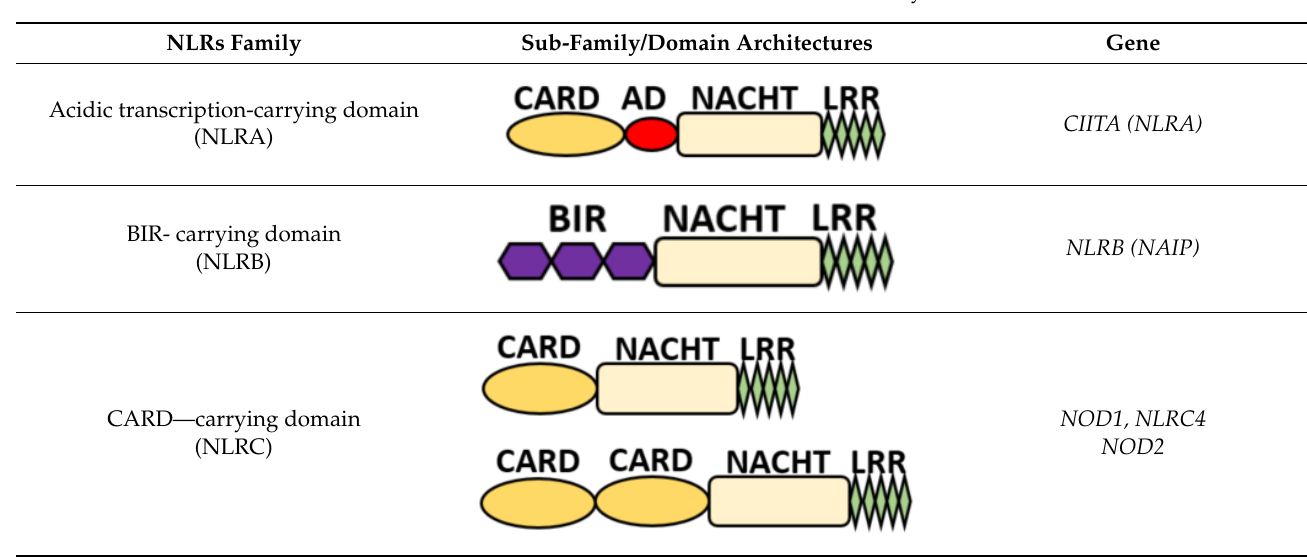
Table 1. Involvement of the NLRs family in chronic inflammatory diseases.